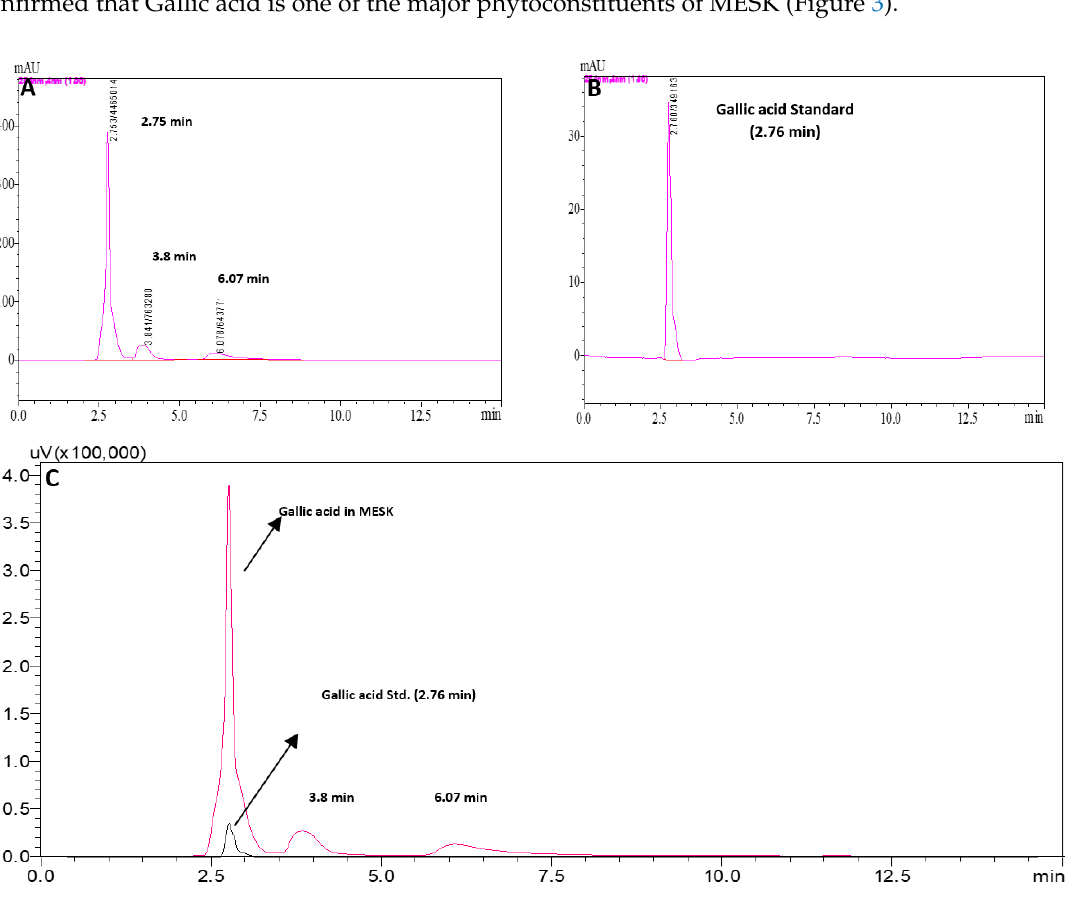
Figure 3. High Performance Liquid Chromatography (HPLC) chromatogram of ( A ) MESK, ( B ) Gallic acid, and ( C ) Overlay of ( A ) and ( B ). HPLC analysis confirmed the presence of Gallic acid as a major bioactive agent in MESK.